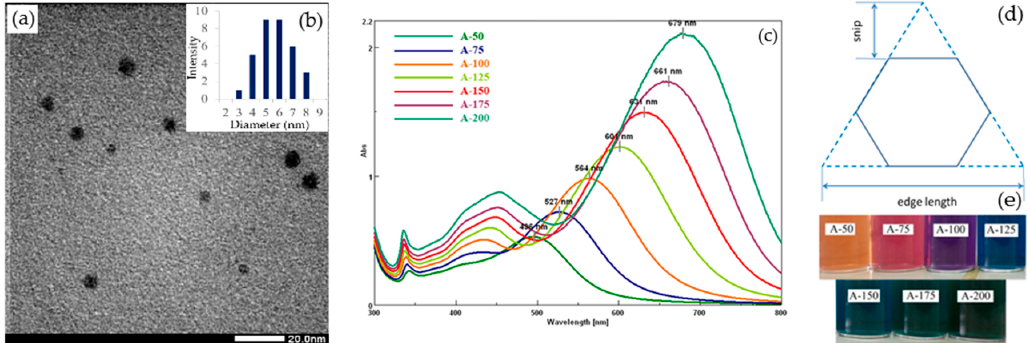
Figure 1. ( a ) Transmission electron microscopy (TEM) images of the initial silver seeds (20 mL AgNO 3 3.0 × 10 − 4 M, 20 mL of TSC 5.0 × 10 − 4 M, 60 μ L solution of NaBH 4 0.1 M), ( b ) the inset of the size distribution of formed seeds (measured by TEM), ( c ) UV-Vis spectra of triangular AgNPs synthesized